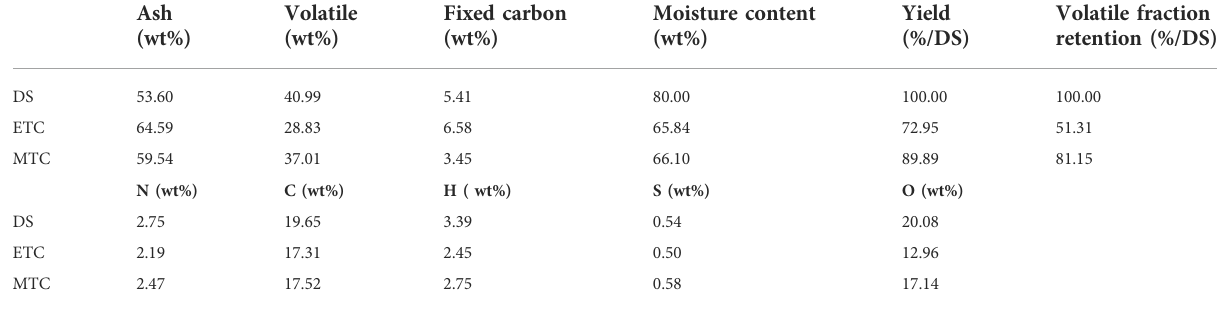
TABLE 1 The proximate and elemental analysis of DS, ETC and MTC.